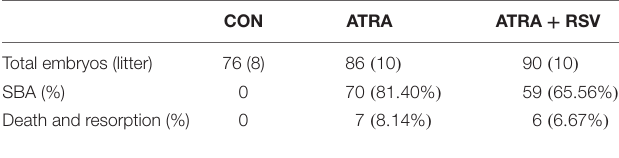
TABLE 2 | RSV treatment reduces the SBA